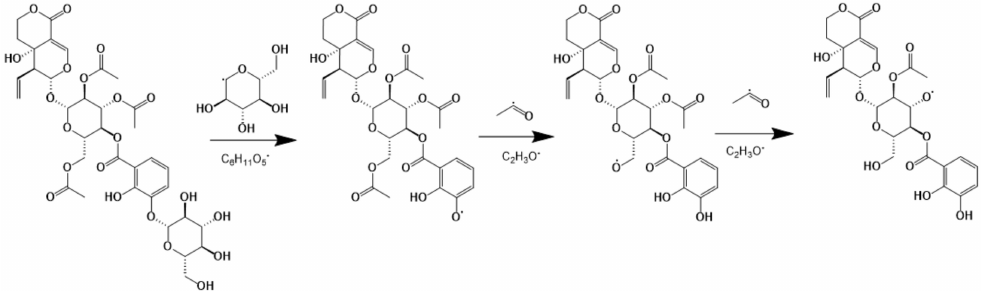
Figure 4. Deductive fragmentation pathway of